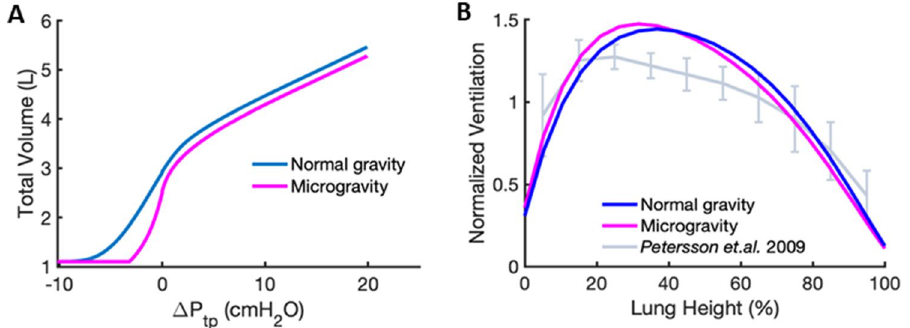
Figure 6. ( A ) Comparison of the deflation limb of the model under normal gravity and microgravity assuming a homogenous distribution of P pl , i = − 3.25 cmH 2 O. ( B ) Comparison of model in normal gravity (blue), microgravity (magenta), and experimental (grey) ventilation versus lung height from base to apex at a (cid:31) P tp = 5 cmH 2 O.